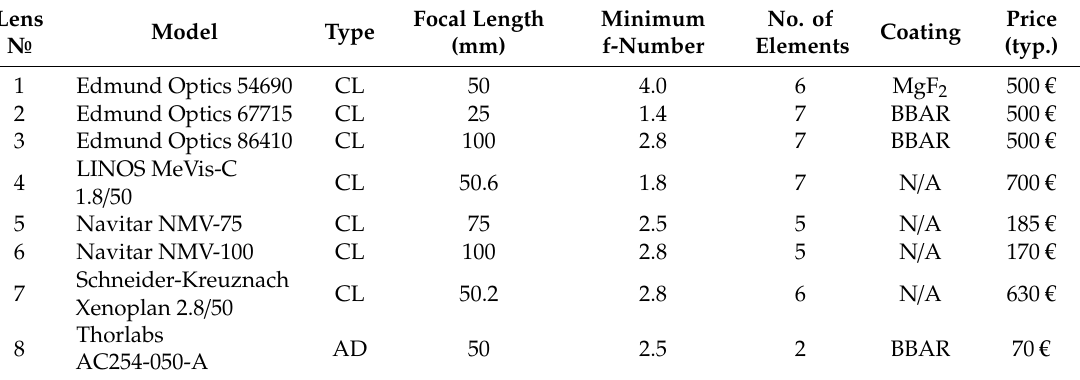
Table 5. Lenses used for the investigations. CL: camera lens, AD: achromatic doublet.